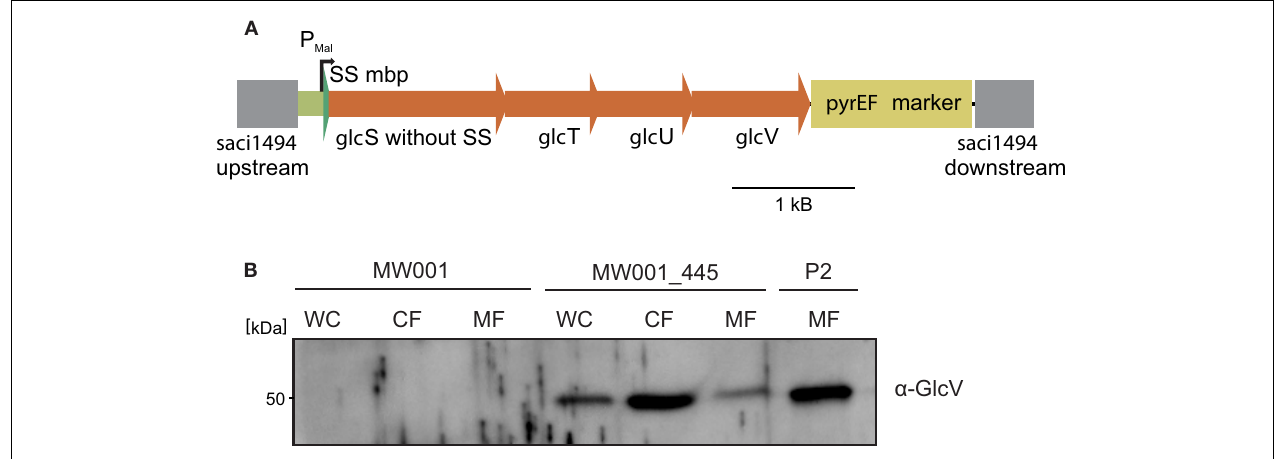
signal peptide from S. acidocaldarius . GlcTU are the predicted permase, whereas GlcV is the ATP binding protein in the glucose ABC transporter. (B) Western blot with specific GlcV antibodies on MW001, MW001_445, and S. solfataricus P2 cells.WC, whole cells; CF, cytoplasmic fraction; MF, membrane fraction.